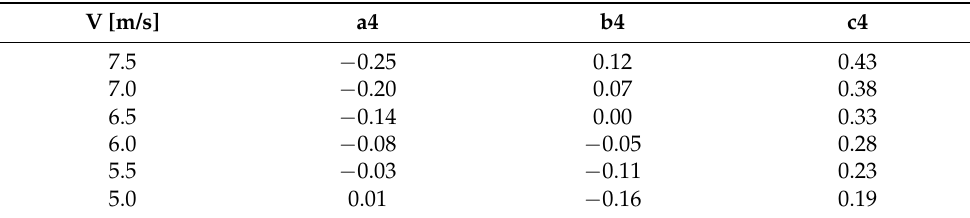
Table 2. Approximation function coefficients for four-segment rotor characteristics.